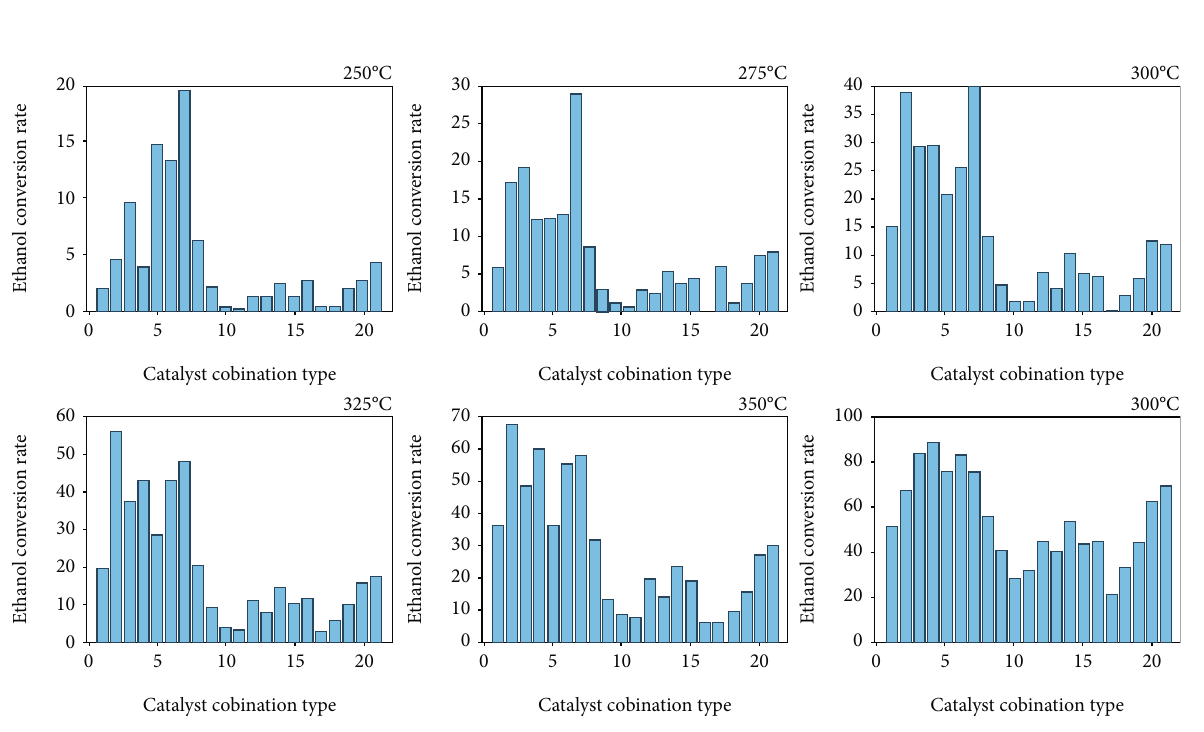
Figure 1: Ethanol conversion rate